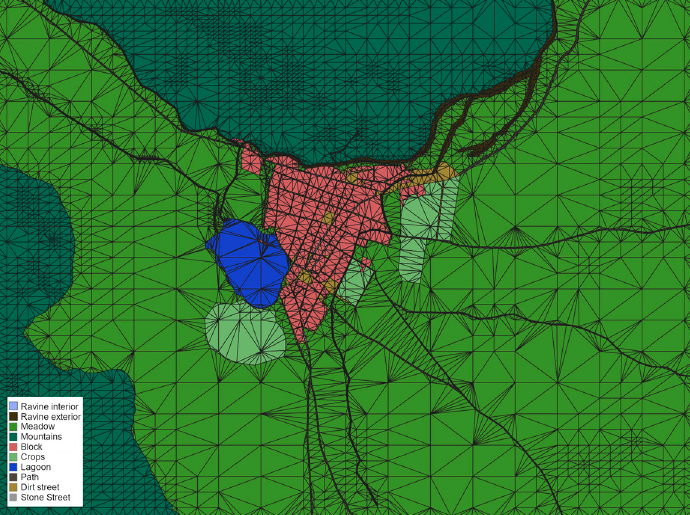
Figure 13. The georeferenced 2D layers related to the terrain constrain the DEM triangulation and generate the 3D model of the terrain.